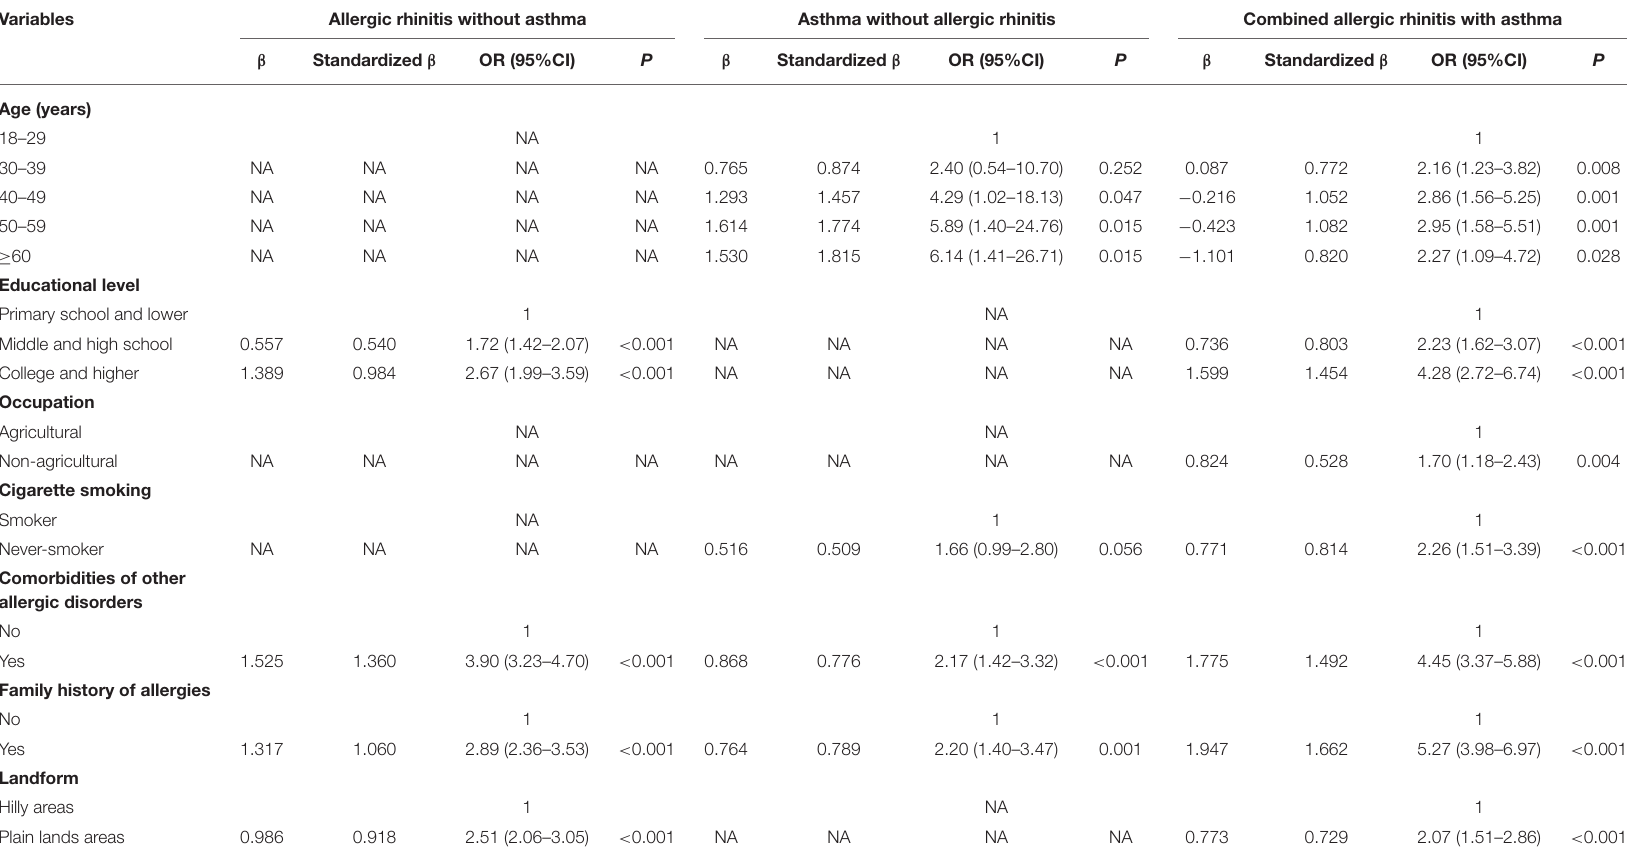
TABLE 3 | Multivariate logistic regression analysis of risk factors for the allergic rhinitis without asthma, asthma without allergic rhinitis, and combined allergic rhinitis with asthma.